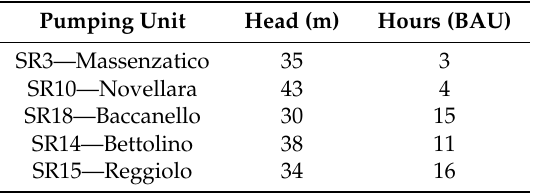
Table 4. Number of operating hours of the pumping units for business as usual (BAU), with total head associated with the relative SR in the networks.